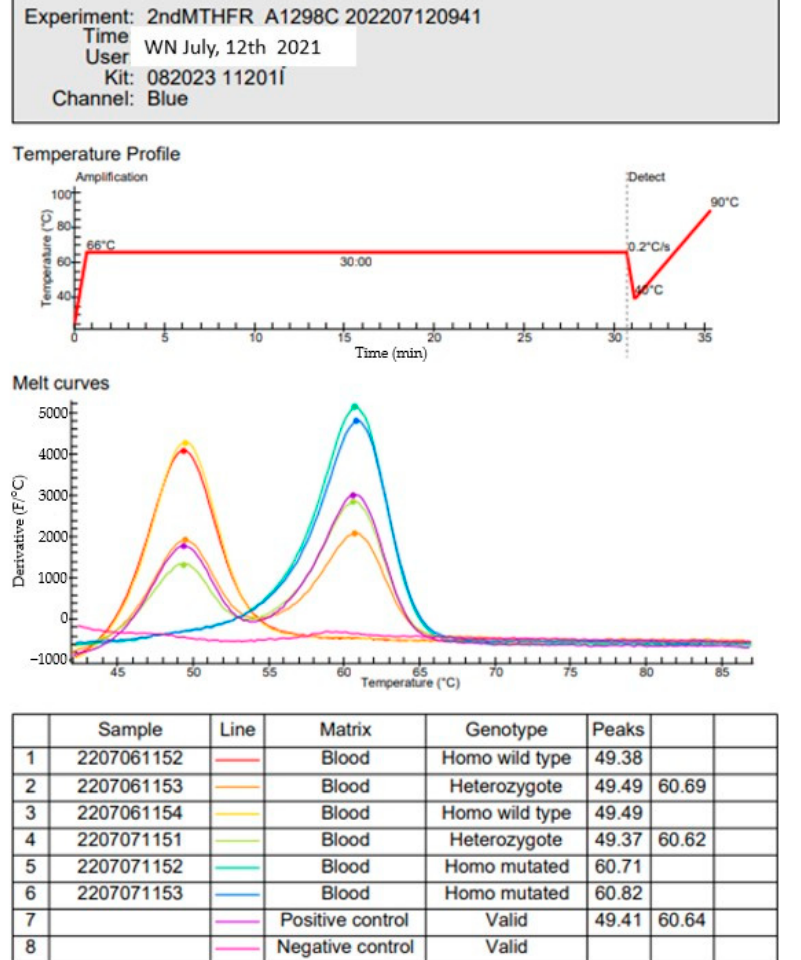
Figure 2. Several patients’ samples are represented in this figure: Amplification for A1298C patient 071,153. The blue line represents patient homozygous C1298C (one peak at 60.8).